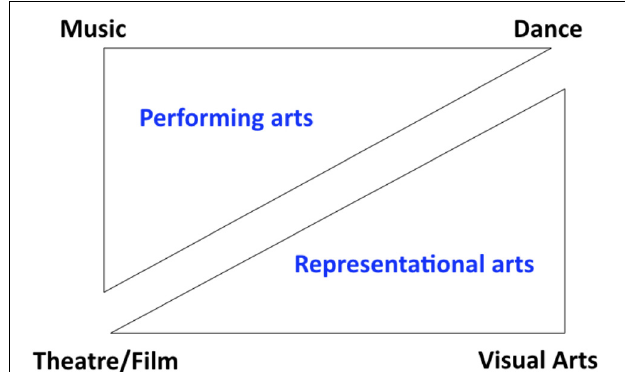
The top triangle is made up of the performing arts, while the bottom triangle is made up of the representational arts. Theater/film and dance sit in both